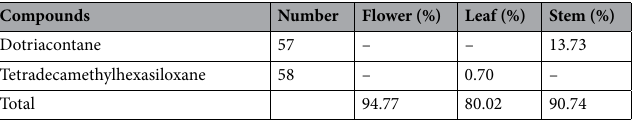
Table 1. Chemical composition of the essential oils extracted from flowers, leaves and stems of O. acanthium .